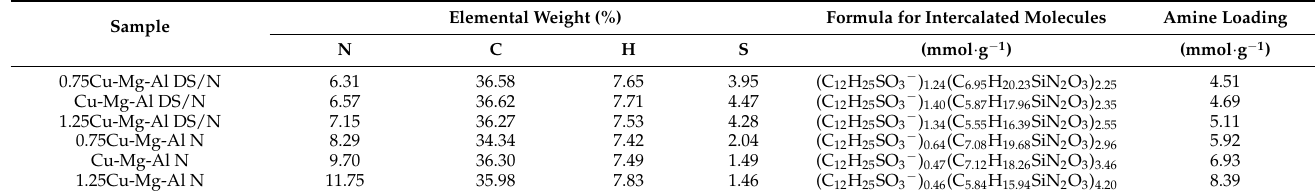
Table 1. Elemental analysis results of xCu-Mg-Al DS/N and xCu-Mg-Al N. Sample Elemental Weight (%) Formula for Intercalated